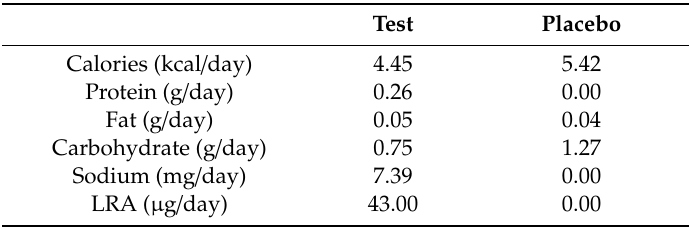
Table 1. Composition of the tablets used in this